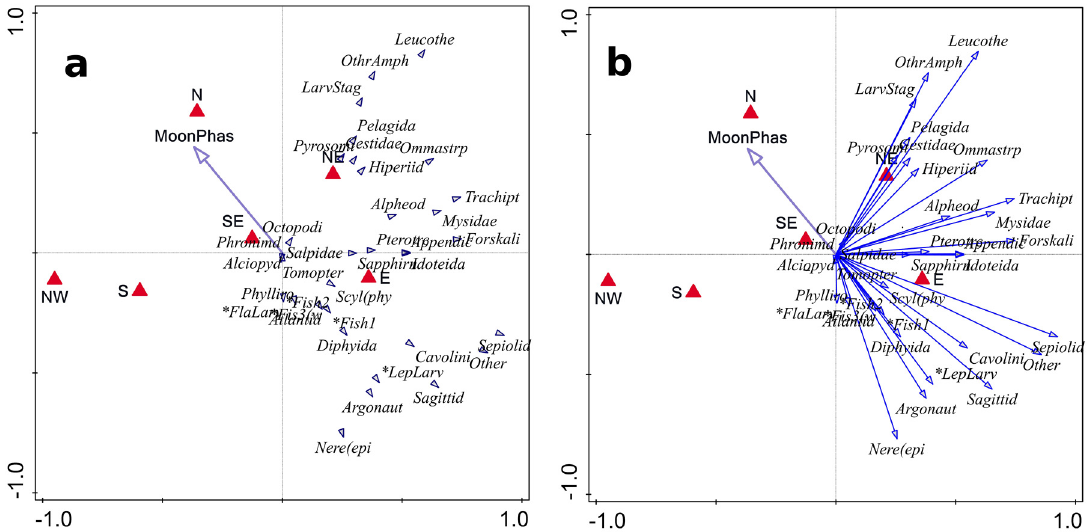
Figure 3. PCA ( a ) of the encountered taxa and the two main environmental factors of moon phase and current directions. PCA with arrows ( b ) highlights the direction of the taxa at increasing values of the environmental variables (performed with CANOCO 5).